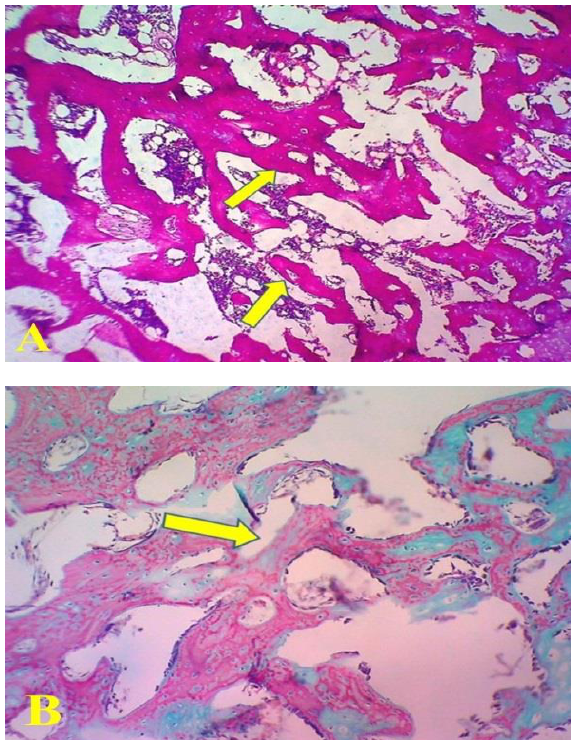
Figure, 6: In the third group at the tenth week, shown proliferation of cartilaginous tissue and its transformation into a new boney tissue, with presence of many new bone trabeculae (arrow). A: H&E X40, B: Masson trichrom